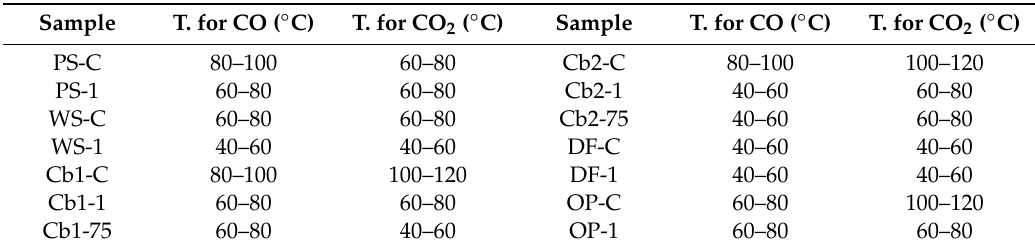
Table 4. Initial gas emission interval temperature.